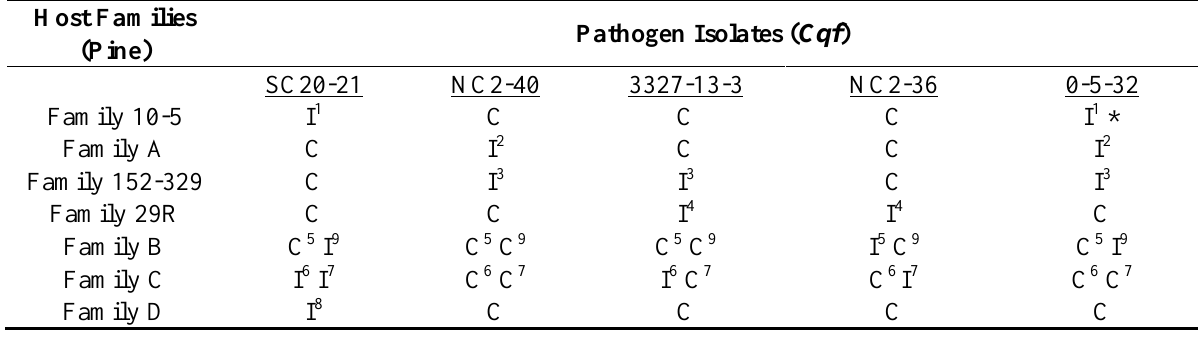
Table 1. Host-pathogen interaction classification for seven loblolly pine families